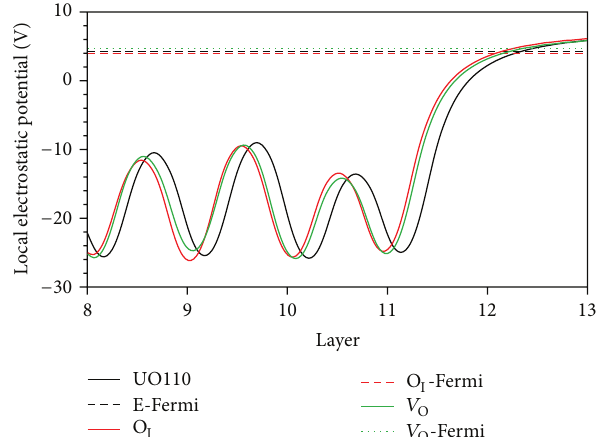
Table 2: Staring and final average layer position of (110)